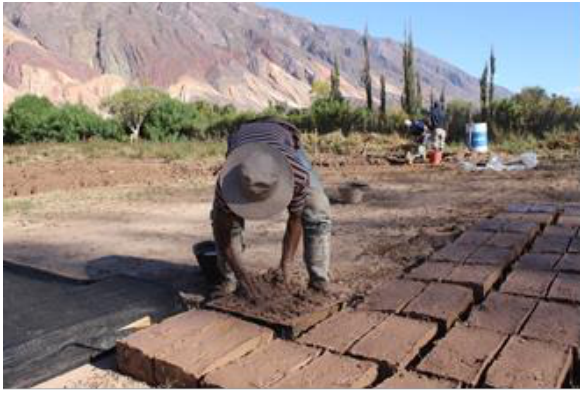
Figure 9. Adobe production in the town of Maimará © Authors.